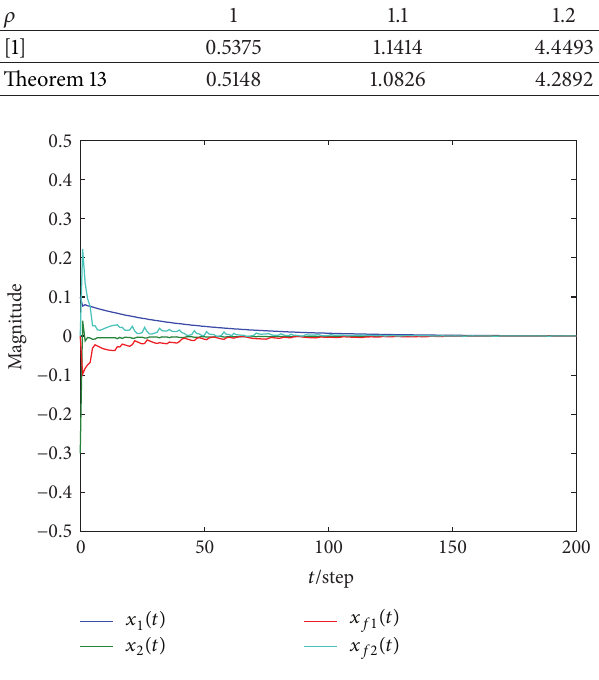
Table 1: Different minimum 𝛾 for uncertain switched system.